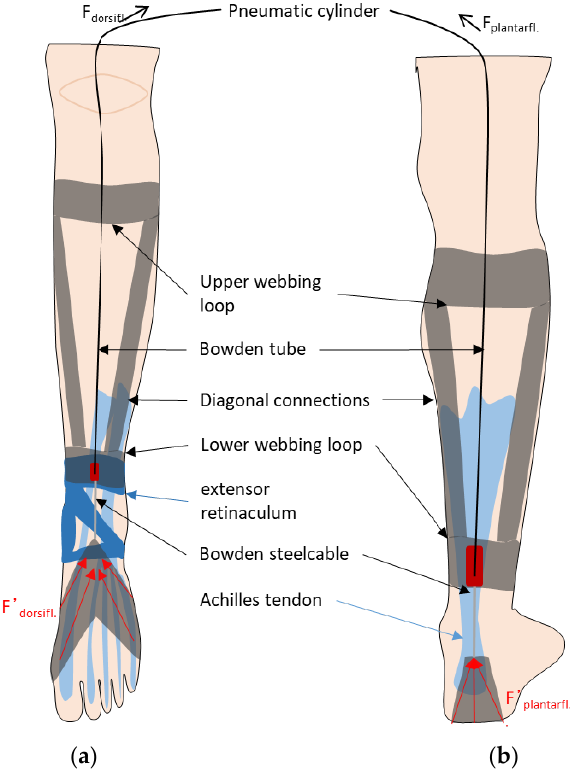
Figure 3. Illustration of ankle tendon and ligament mechanism and overlaying exosuit concept of ( a ) front side of lower leg to induce dorsiflexion and ( b ) back side of lower leg to induce plantar-flexion.